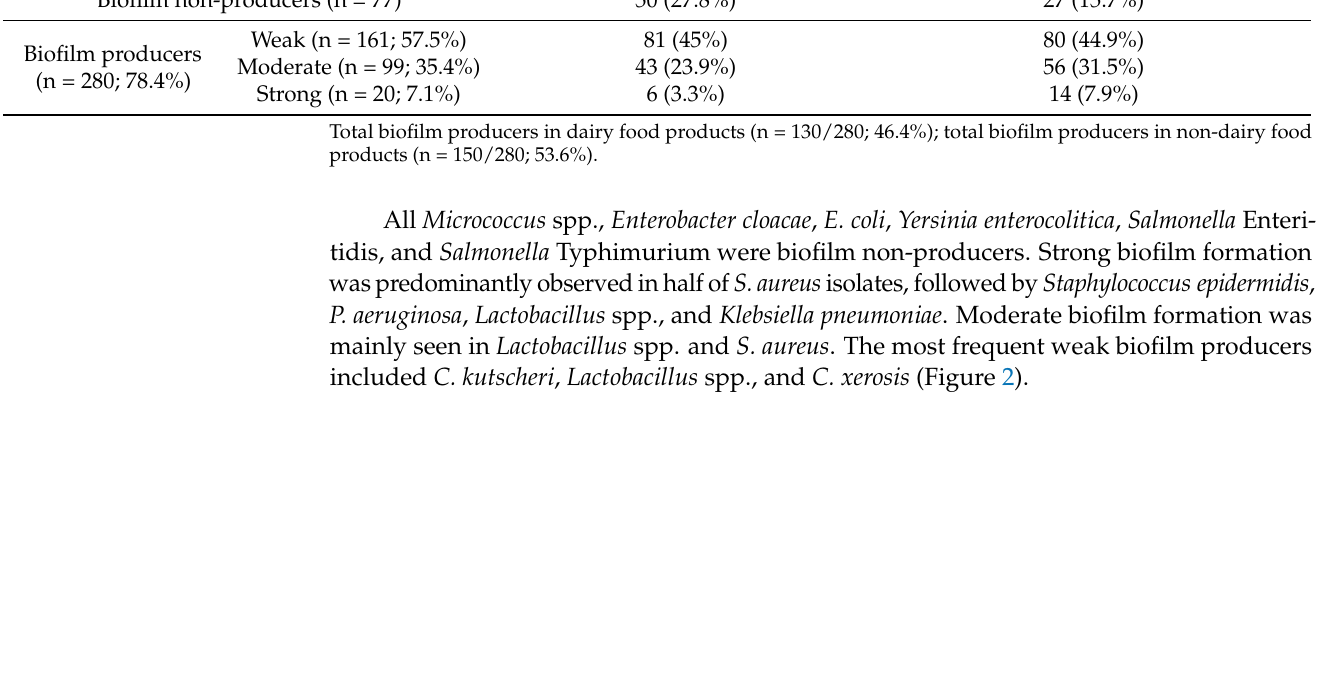
Table 3. Types of biofilm produced by bacteria isolated from different food sources (n = 357).